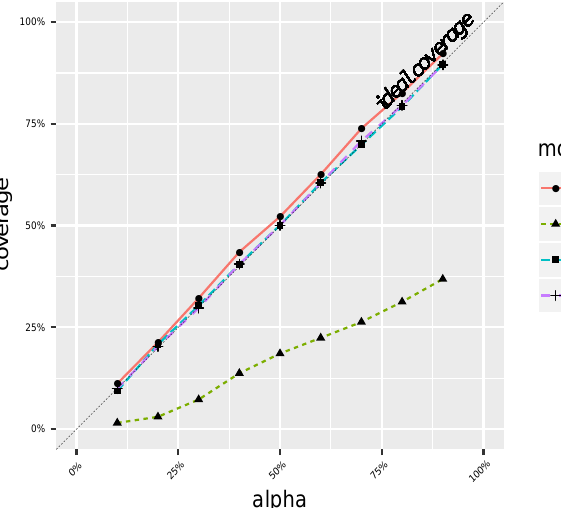
Figure 4. Coverage values from the log-normal data.